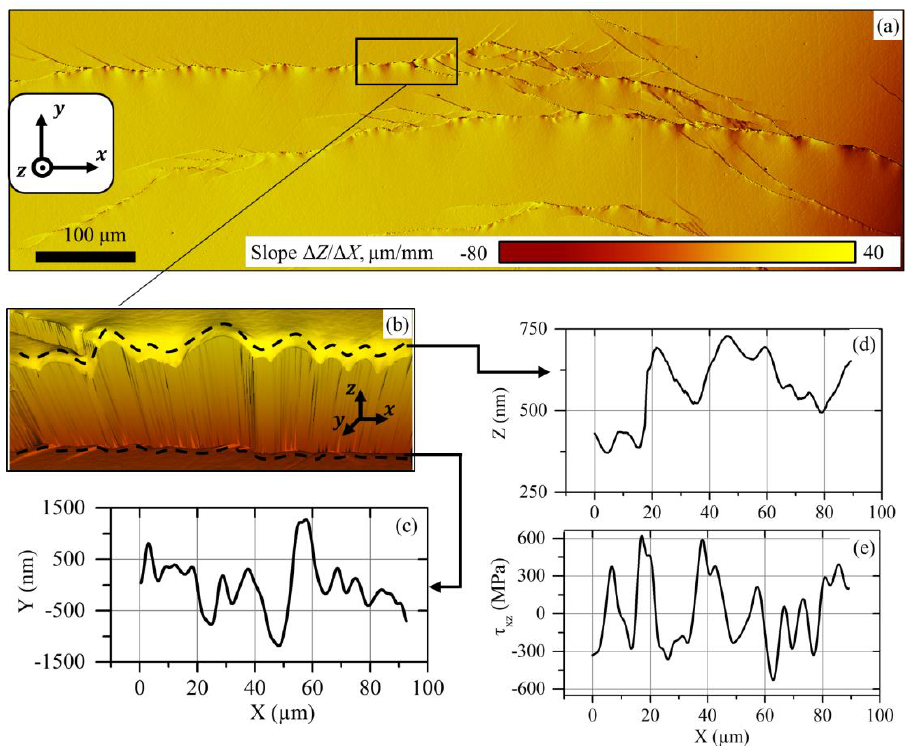
Figure 4. Fluctuations of the shear band (SB) steps on the polished surface of the Pd-based bulk metallic glass (BMG) specimen tested in compression. The 3D surface map obtained with the scanning white-light interferometry (SWLI) technique is represented as a slope map, clearly showing a wavy character of SB steps ( a ). A magnified view of the area in a black rectangular ( a ) is shown in the isometric view below ( b ), where colour scale represents height Z in the range of 750 nm. Profiles of the SB step in XY and XZ planes are shown qualitatively with the dashed lines ( b ) and quantitatively on graphs ( c , d ), respectively, including the shear strain introduced by shear step deviations ( e ). As suggested by Gilman, the observed path deviations up to 30% would produce the elastic energy increase of less than 10% [49]. The shear stress τ xz introduced by the offset fluctuation can be estimated via the Cauchy’s infinitesimal strain γ xz tensor as: 1 (𝑑𝑥 𝑑𝑧 𝐺 𝑑𝑧 𝜏 𝑋𝑍 = 𝐺 ∙ 𝛾 𝑋𝑍 = 𝐺 + 𝑑𝑥) = 𝑑𝑥, (1) 2 𝑑𝑧 2 where G = 35.5 GPa is the shear modulus of the Pd 40 Cu 30 Ni 10 P 20 alloy [2]. The calculated local shear stress value varies in the range of ± 600 MPa (Figure 4e). It is worth mentioning that a real stress range is likely even larger, considering the of 45° angle between a shear plane and the scanned surface. Such large stress values up to 1 GPa result from the accumulation of several (up to 10 in observed “old” SB) successive shear events on one plane. This means that the stress oscillations along the SB, introduced by one mode III shear event, should be of an order of magnitude smaller, i.e., around 100 MPa. However, the calculation of strains performed by Binkowski et al. [17] shows that the strain